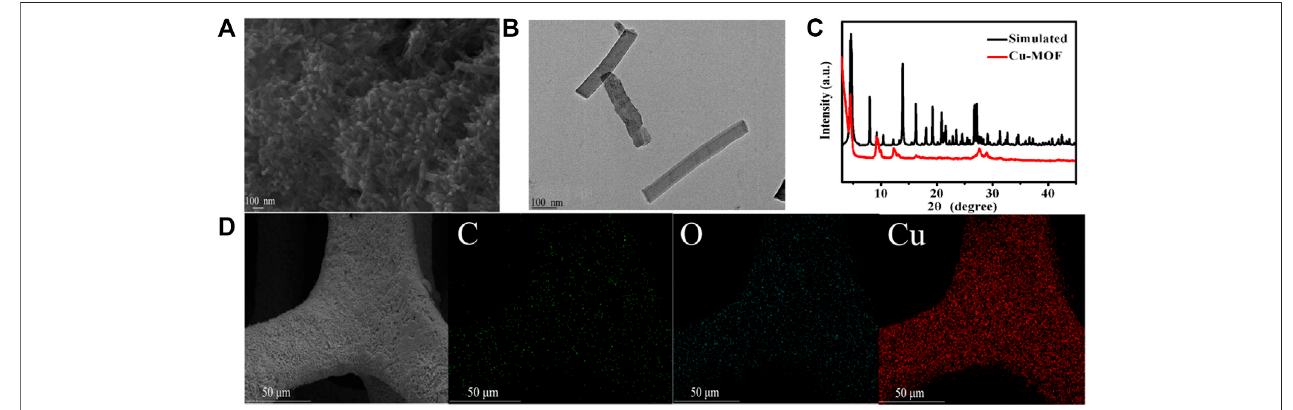
FIGURE 2 | XPS spectrum for the Cu-MOF: (A) survey spectrum (B) C 1s, (C) O 1s, and (D) Cu 2p.